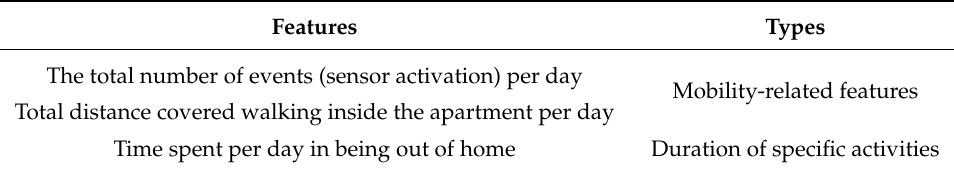
Figure 14. The total number of captured events per location for re-deployment testbed dataset. 5.2. The Number of Captured Events and Total Covered Distance The inhabitant’s daily covered distance can be estimated by knowing the apartment’s floorplan and the placement of sensors within the apartment. The dimensions of the rooms, distances between the centre of each area with the next one and distances between sensors are calculated accurately. Then, for every pair of events captured by a single sensor, two points are selected randomly within that area or two points are selected from two adjacent areas for every captured transition and then the distance between these two points is calculated. Adding all of the calculated distances throughout the day provides an approximation of the daily total covered distance. Note that this approach does not consider the existence of walls or other obstacles in the path of movements and assumed the resident walked in a straight line from the area covered by one sensor to another area covered with